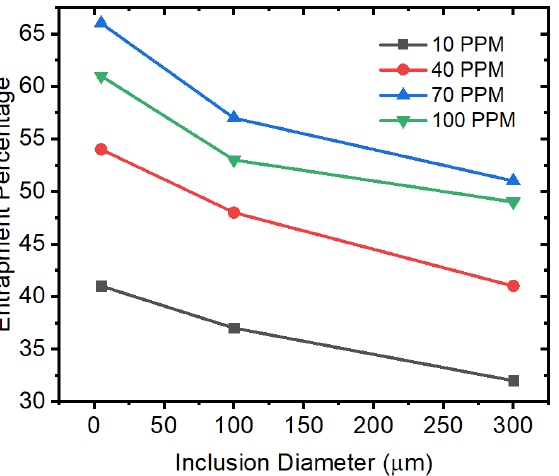
Figure 16. Entrapment (at the top surface) of alumina inclusions under different conditions of sulfur concentration and inclusion diameters.